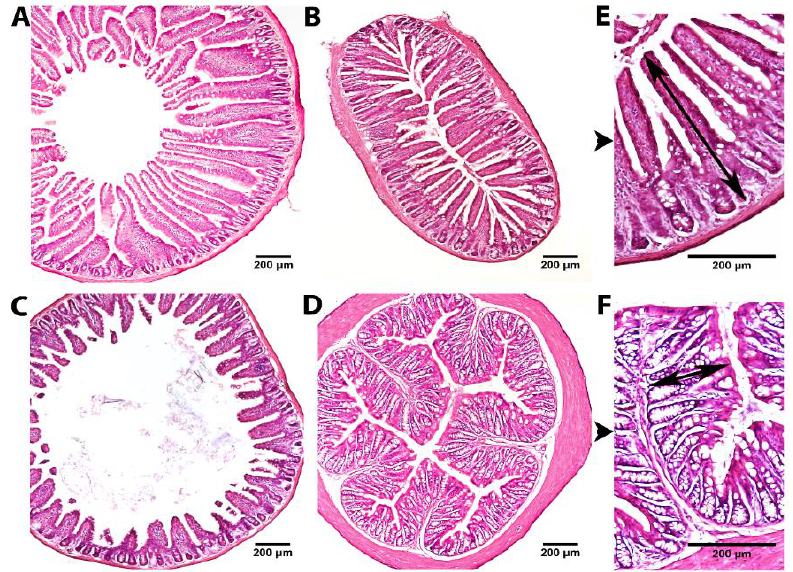
Figure 2. Representative images of H&E staining of the duodenum ( A ), jejunum ( B ), ileum ( C ) and upper colon ( D ) at × 40 magnification and jejunum ( E ) and upper colon ( F ) at × 100 magnification. Black arrows mark the mucosal thickness measurement. Table 1. Effect of fruit proteases feeding during a 3-day period on the mucosal thickness of the small and large intestines in mice.